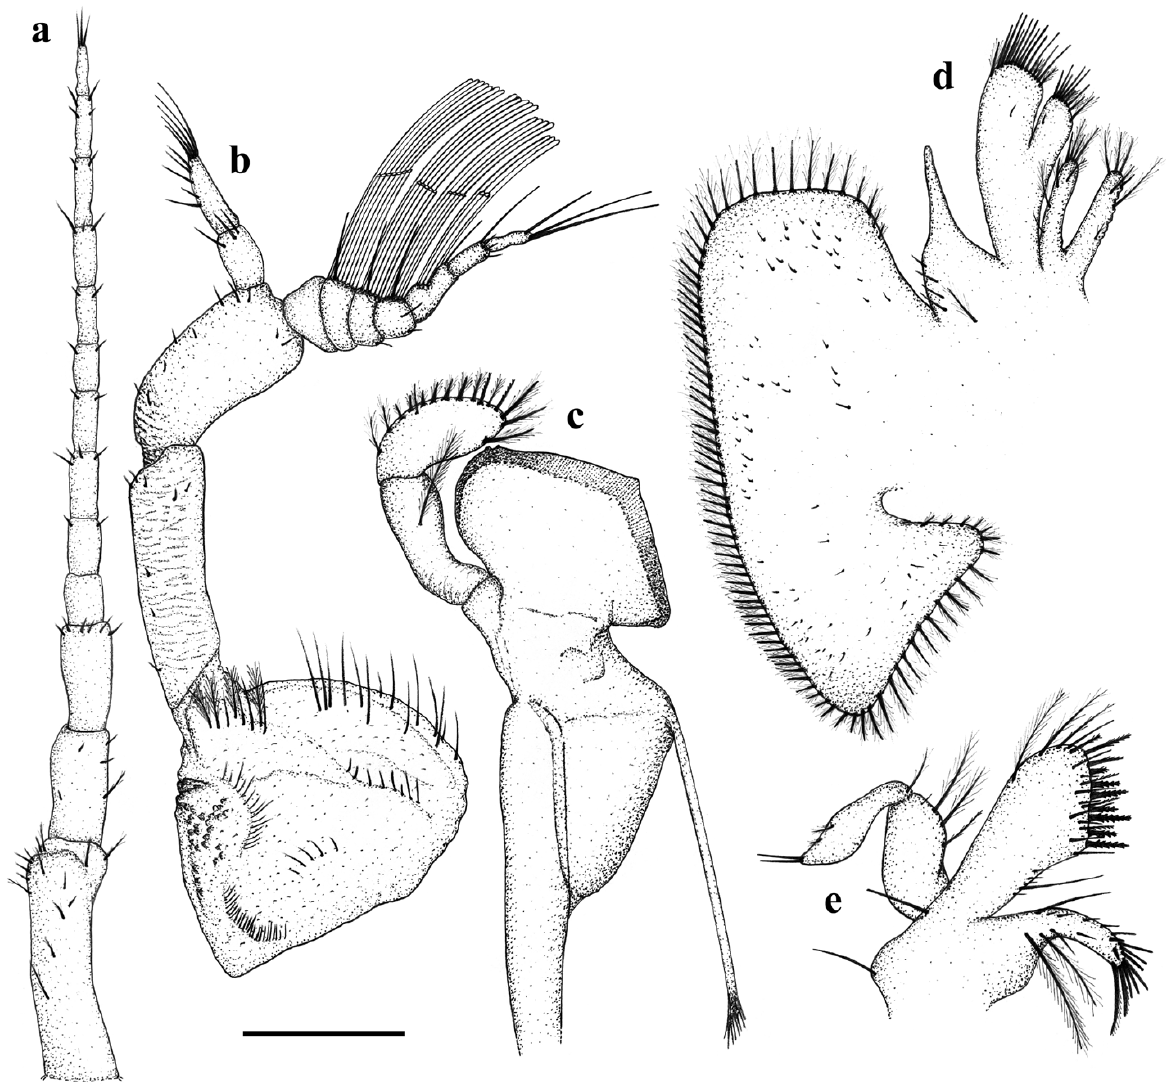
Figure 2 - Callinectes danae . 1 st undifferentiated stage: A , antenna; B , antennules; C , mandible; D , maxilla; E , maxillule. Scale: